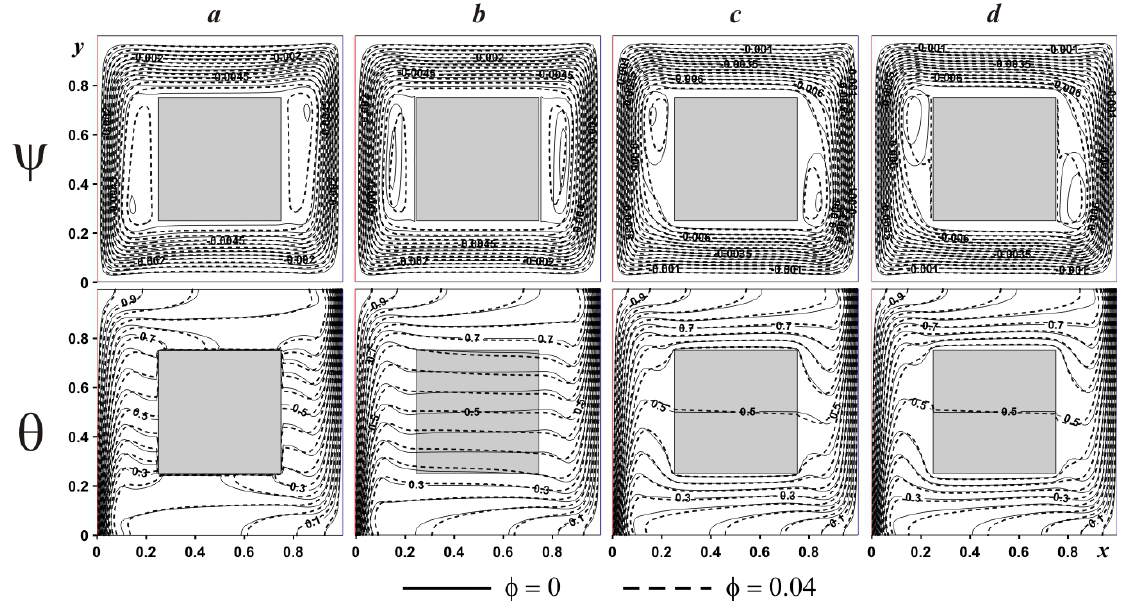
Figure 15. Isolines of ψ and θ for heat-conducting internal body at Ra = 10 6 and different K and φ : ( a )— K = ∞ , ( b )— K = 0.68, ( c )— K = 0.04, ( d )— K = 0.004.